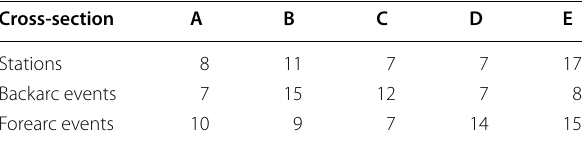
of earthquakes and